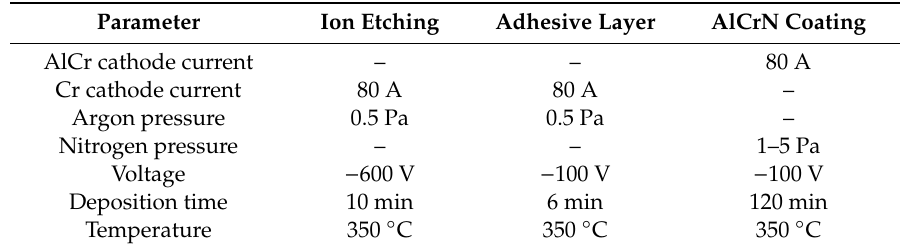
Table 1. Basic technological parameters for synthesizing AlCrN coatings. Parameter Ion Etching Adhesive Layer AlCrN Coating AlCr cathode